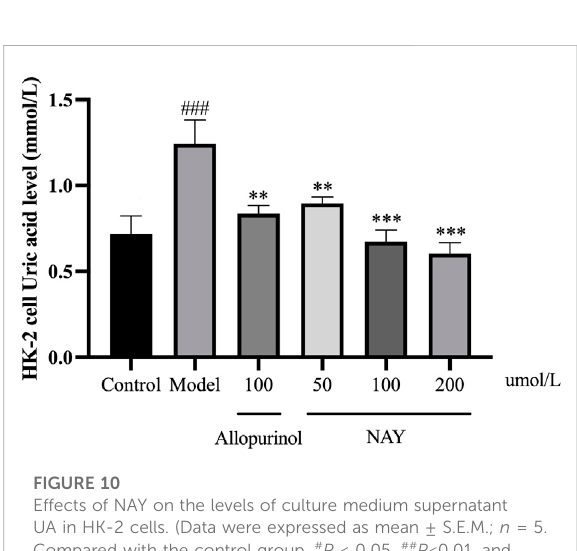
FIGURE 10 Effects of NAY on the levels of culture medium supernatant UA in HK-2 cells. (Data were expressed as mean ± S.E.M.; n = 5. Compared with the control group, # P < 0.05, ## P < 0.01, and ### P < 0.001. Compared with the model group, * P < 0.05, ** P < 0.01, and *** P <